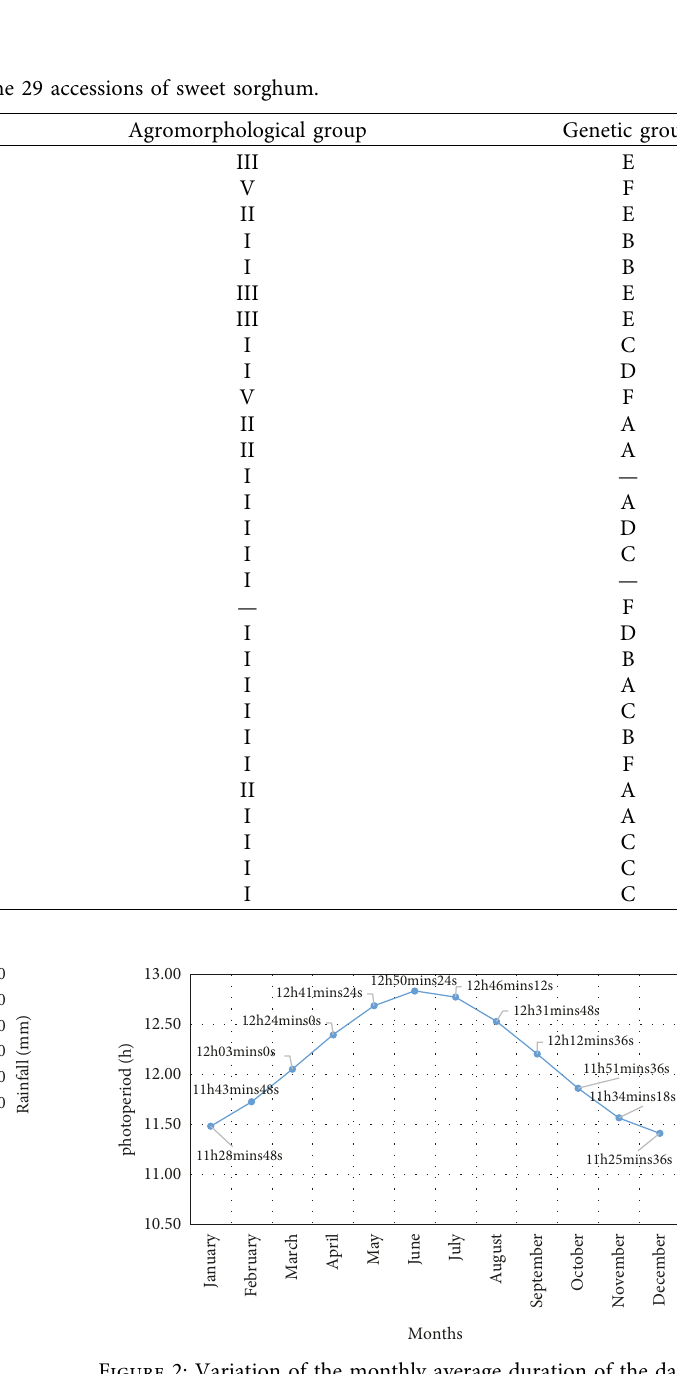
Figure 1: Variation of rainfall and temperature in the experiment site of “Gamp`ela” station [31].